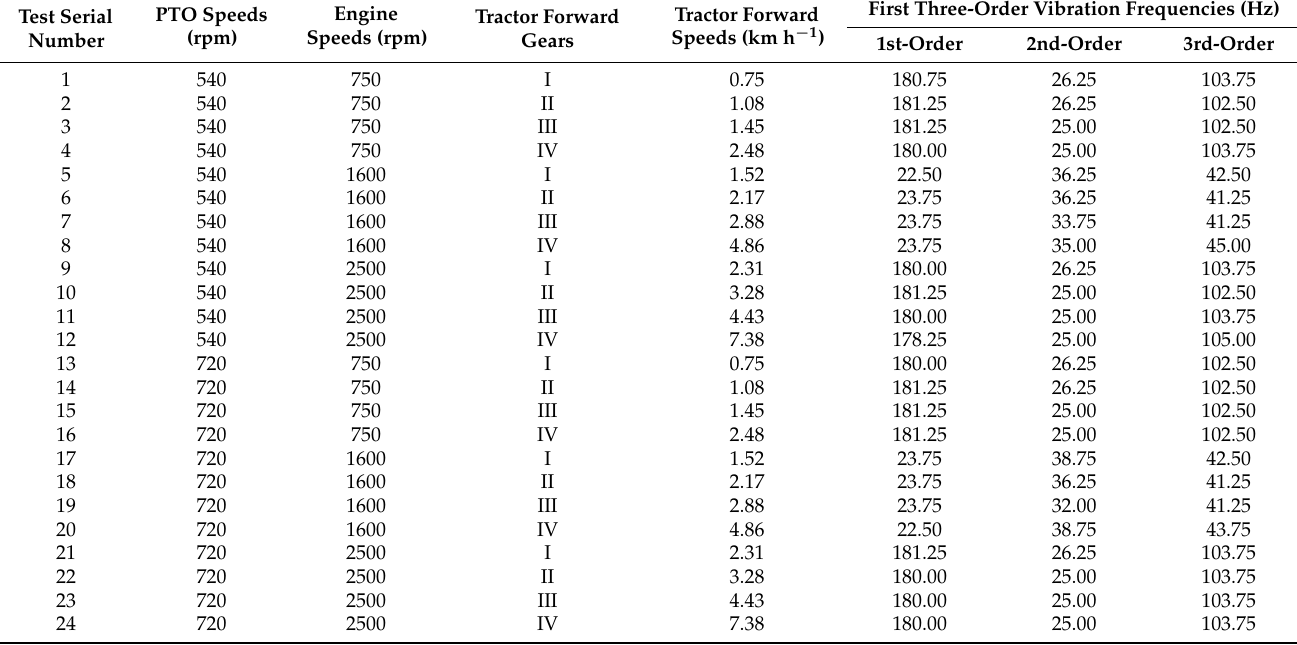
Table 3. First three ‐ order vibration frequencies of seed ‐ metering device.